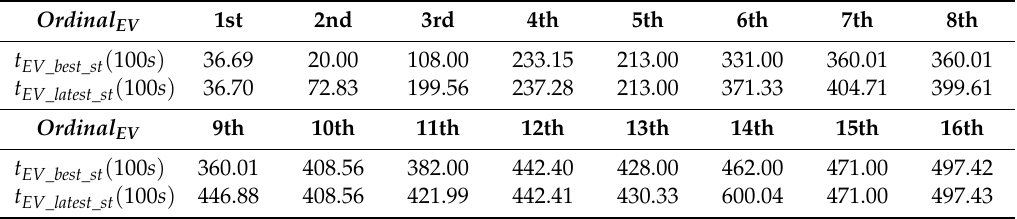
Table 4. Theoretical optimal start operating time and latest start operating time of EVs.